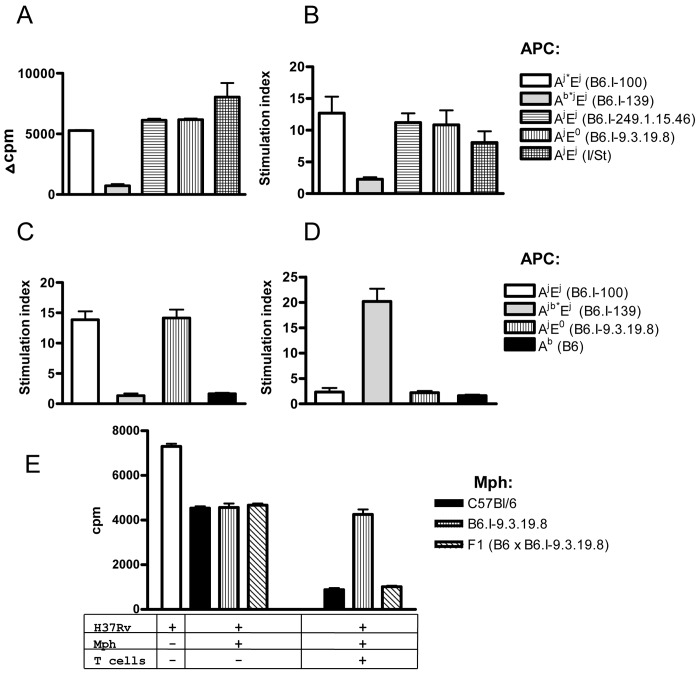
CD4+ T cells recognize mycobacterial antigens in the context of H2-A molecule.Mycobacterial antigens were presented by APC expressing different gene combinations and alleles of Class II molecules (see legend) to: (A) polyclonal I/St T cell line, or to highly purified immune lymph node CD4+ T cells (pooled from 2–3 mice) from I/St (B), B6.I-100 (C) and B6.I.139 mice (D). Representative data from one out of two similar independent experiments are presented, results are expressed as mean ± SEM of triplicate cultures. Y-axis: Δ cpm (counts per minute) = mean cpm of antigen-stimulated wells—the mean cpm of non-stimulated wells. Stimulation index (SI) mean cpm of antigen-stimulated wells/ mean cpm of non-stimulated wells. (E)–CD4+ T-cells from (B6 x B6.I-9.3.19.8) F1 mice stimulate bacteriostatic activity of B6 and F1, but not of B6.I-9.3.19.8 macrophages (mph). Results are present as [3H]-uracil uptake from one out of two experiments provided similar results (CPM ± SEM for triplicates, P < 0.001, ANOVA). See Materials and Methods for details.